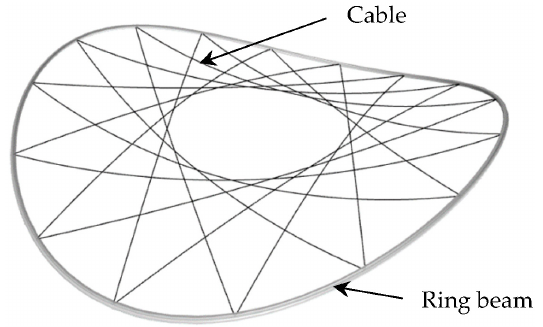
Figure 1. Diagram of the loop-free single-layer hyperbolic cable net structure.